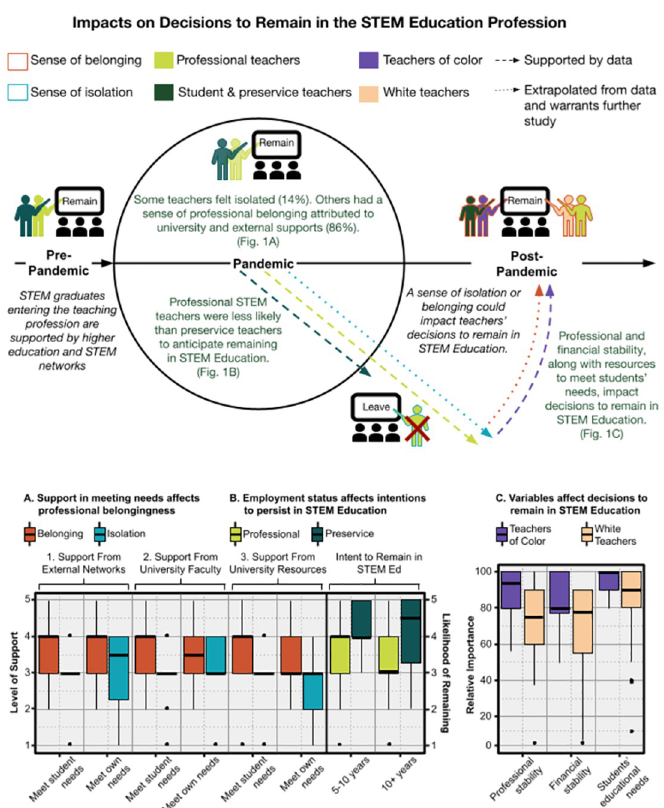
Fig 1. Pathway to supporting STEM teachers as educational and STEM professionals with the goal of retaining them in STEM education. Box plots A.1-3 show that external networks, university faculty, and university resources are important factors in teachers’ sense of belonging. Box plots B show that professional teachers indicate that they are less likely than preservice teachers to remain in the STEM education profession for the long term. Box plots C shows that teachers of color (TOC) are more likely to identify professional stability, financial stability, and students’ educational needs as impacts on their decision to remain in STEM education. The lines depict the potential pathways (i.e., remain or leave) for teachers as they balance supports and barriers, and the levers that might influence these decisions (e.g., professional belonging, resources,